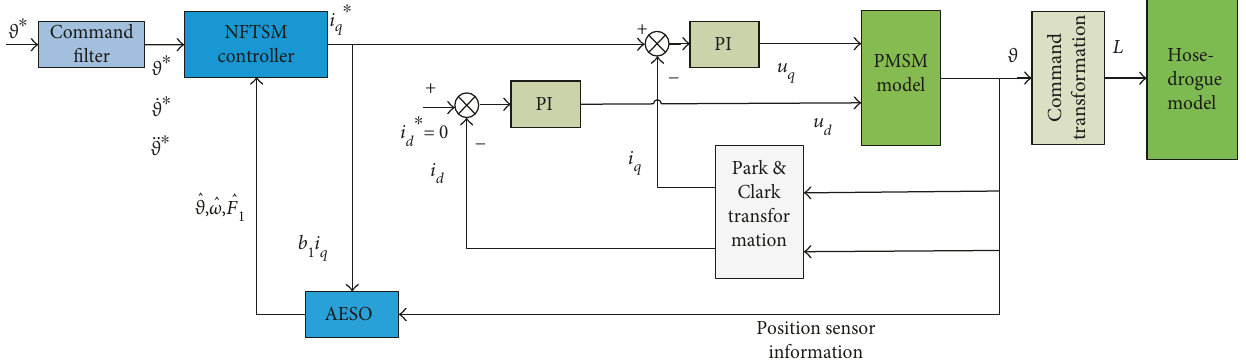
Figure 3: Block diagram of the PMSM control system for refueling hose vibration suppression in